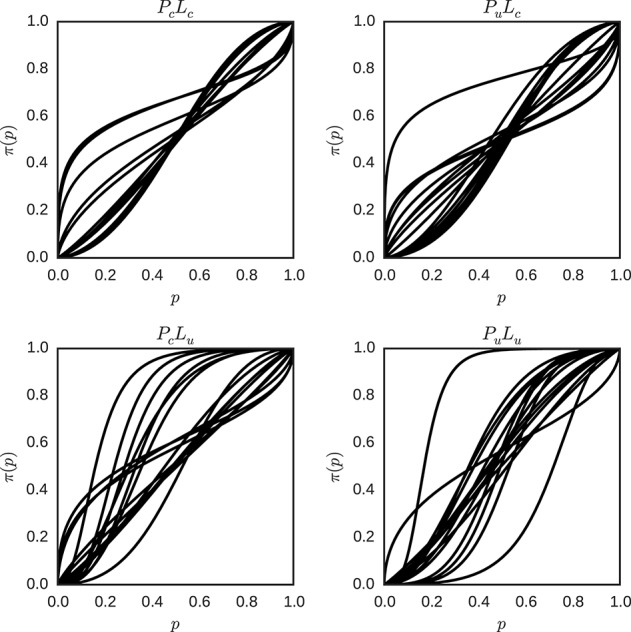
Individual probability weighting functions using the posterior mean for γ and p0 with unrestricted inter-individual differences for the different conditions (PcLc, PuLc, PcLu, and PuLu). Each plot represents one condition, and each line represents the best estimate obtained for the weighted probability function for one individual in that condition.